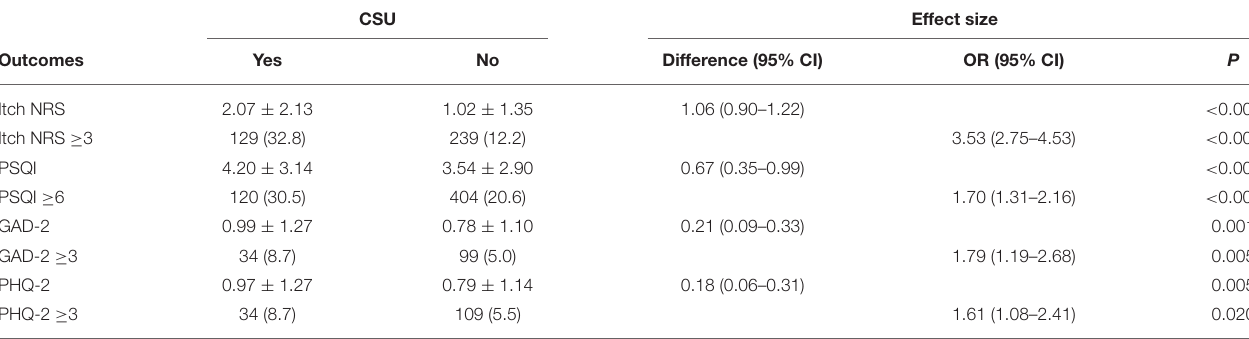
TABLE 2 | Comparison of itch, sleep quality, anxiety, and depression among adolescents with chronic spontaneous urticaria and those without.